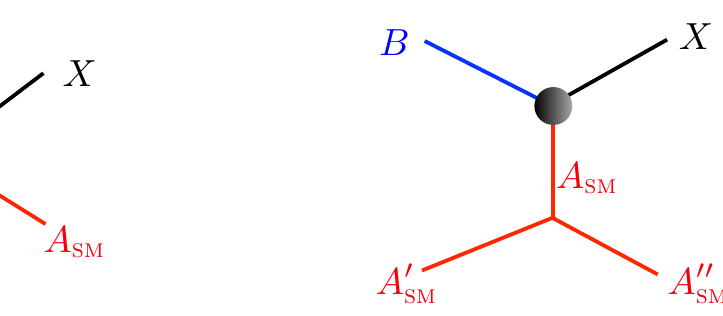
Figure 1. Basic setup of this work: a FIMP X couples to the thermal bath via a cubic interaction with a SM particle A and a new BSM particle B . This sources X production via B decays (left SM panel) and binary collisions (one example in the right